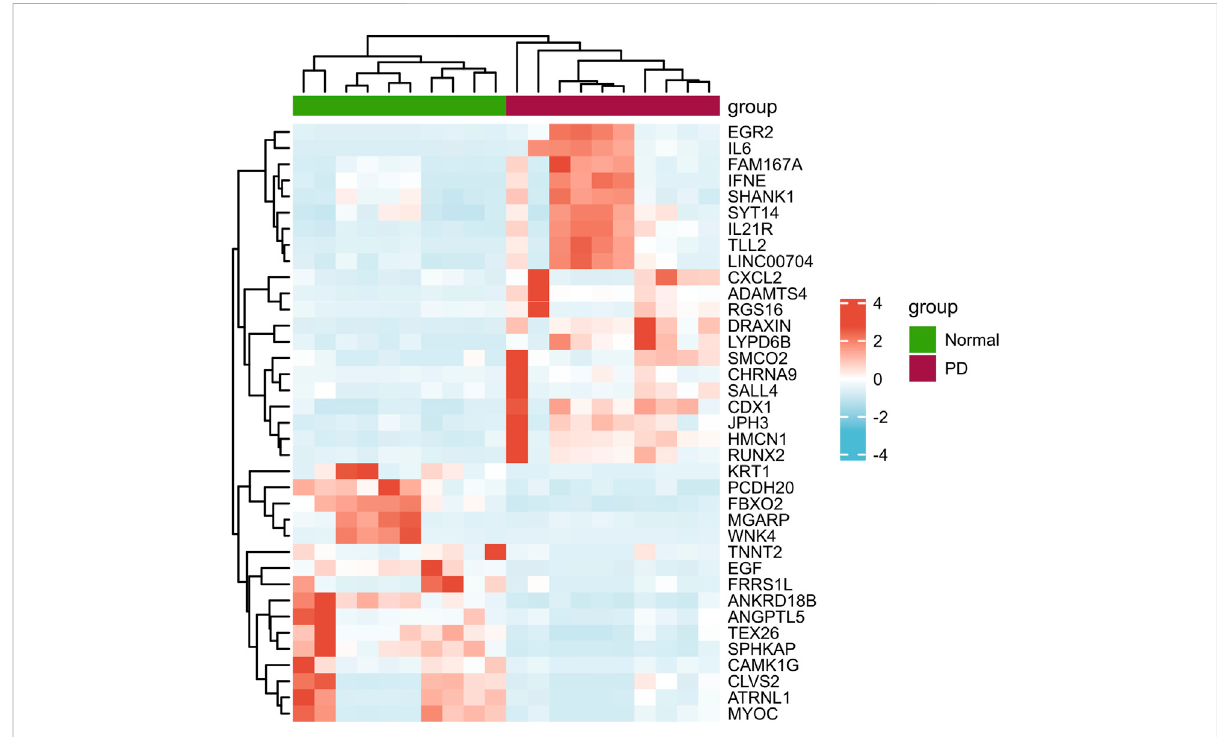
FIGURE 3 Heatmap of the 37 Differentially Expressed Genes in PD and Healthy Samples. PD = Peyronie ’ s